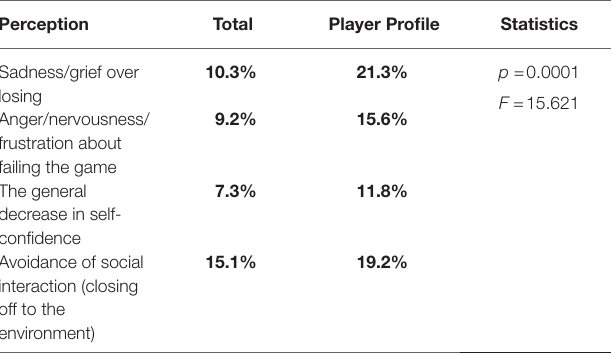
TABLE 2 | Reported negative mental health feelings related to gaming by respondents.